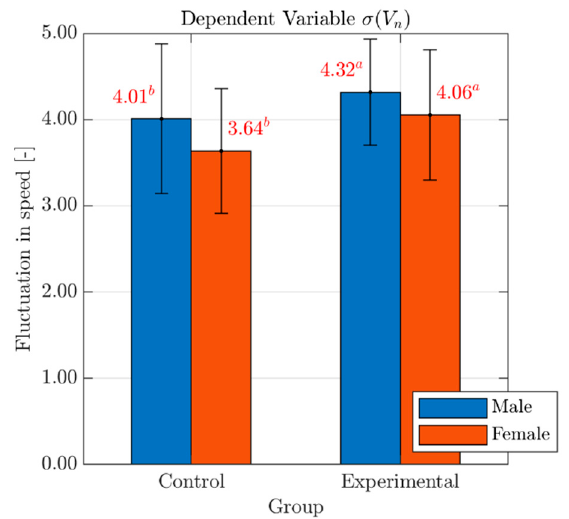
Figure 8. E ff ects of Gender and Group on the variable σ ( V n ) . Legend : Red numbers above the bars Figure 8. Effects of Gender and Group on the variable (cid:2026)(cid:4666)(cid:1848) (cid:3041) (cid:4667) . Legend : Red numbers above the bars represent mean values of the variable σ ( V n ) , for males (blue bar) and females (red bar) in each Group. Figure 8. Effects of Gender and Group on the variable (cid:2026)(cid:4666)(cid:1848) (cid:3041) (cid:4667) . Legend : Red numbers above the bars represent mean values of the variable (cid:2026)(cid:4666)(cid:1848) (cid:3041) (cid:4667) , for males (blue bar) and females (red bar) in each Group. Statistically significant di ff erences are indicated by di ff erent superscript letters. Standard deviation Statistically significant differences are indicated by different superscript letters. Standard deviation represent mean values of the variable (cid:2026)(cid:4666)(cid:1848) (cid:3041) (cid:4667) , for males (blue bar) and females (red bar) in each Group. error bars are also reported for each Statistically significant differences are indicated by different superscript letters. Standard deviation error bars are also reported for each sub-group. error bars are also reported for each sub-group.